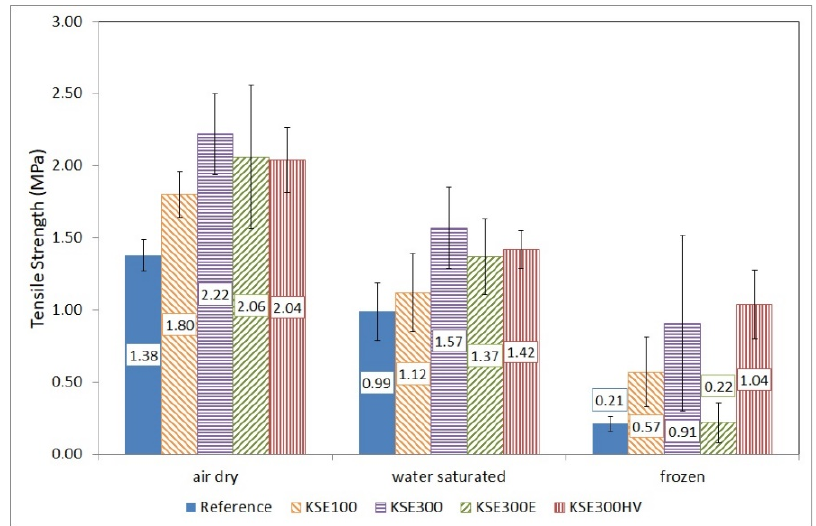
Figure 11. Tensile strength of untreated and treated medium-grained porous limestone from Sóskút (SM) in air dry, water-saturated conditions and after 10 freeze–thaw cycles. The FR limestone untreated samples have the lowest strength reduction linked to water saturation. The strength of water saturated sample is 76% compared to the dry reference sample. The consolidation with KSE 300 reduced the strength loss; it is only 82% for the water saturated consolidated sample compared to the air dry consolidated one.